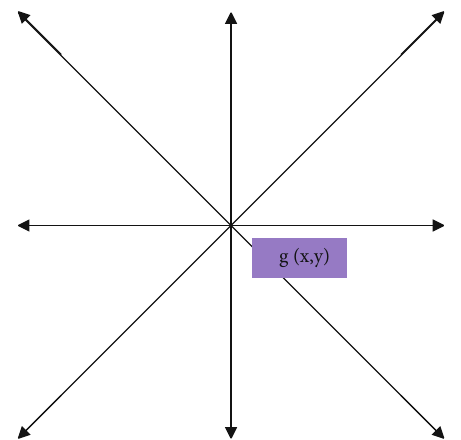
Figure 5: Schematic diagram of the direction of fractional differential